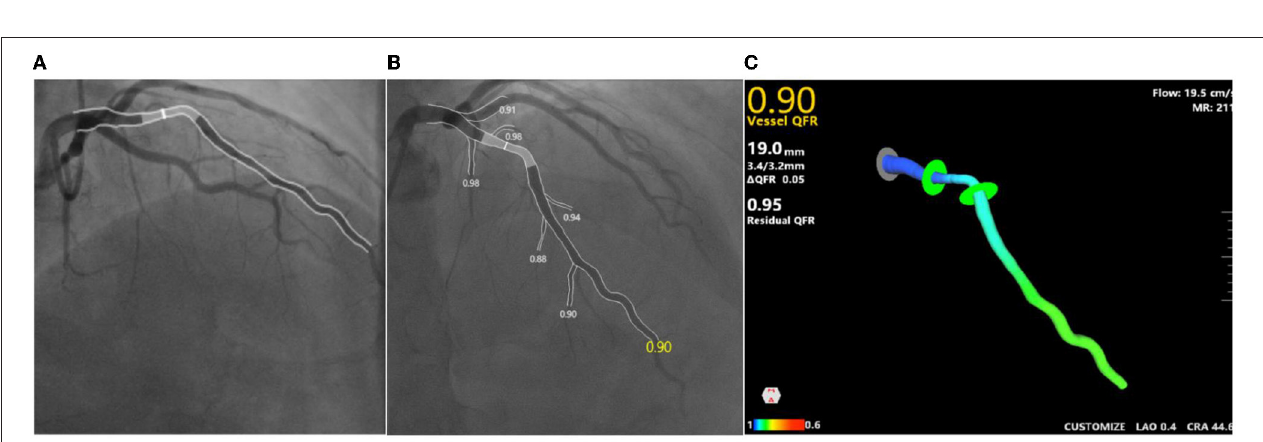
FIGURE 2 | An example of plaque analysis. The ratio of plaque is fibrotic: 43%, lipidic: 13%, necrotic: 42%, and calcified: 2% representatively.